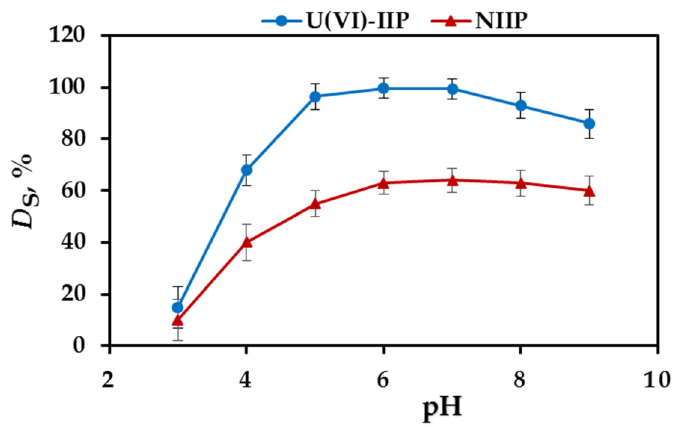
Figure 3. The effect of pH on the extraction efficiency of U(VI) ions with U(VI)-IIP and NIIP (three parallel experiments).